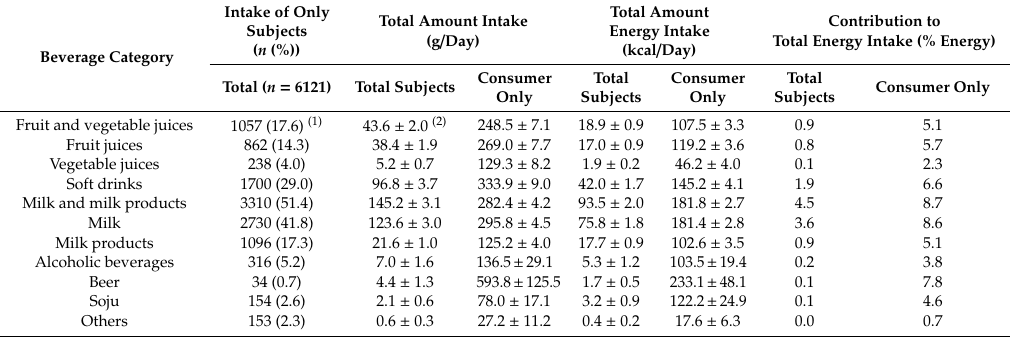
Table 2. Beverage consumption of the Korean children and adolescents aged 10–18 years in the KNHANES V, VI and VII (2010–2018).